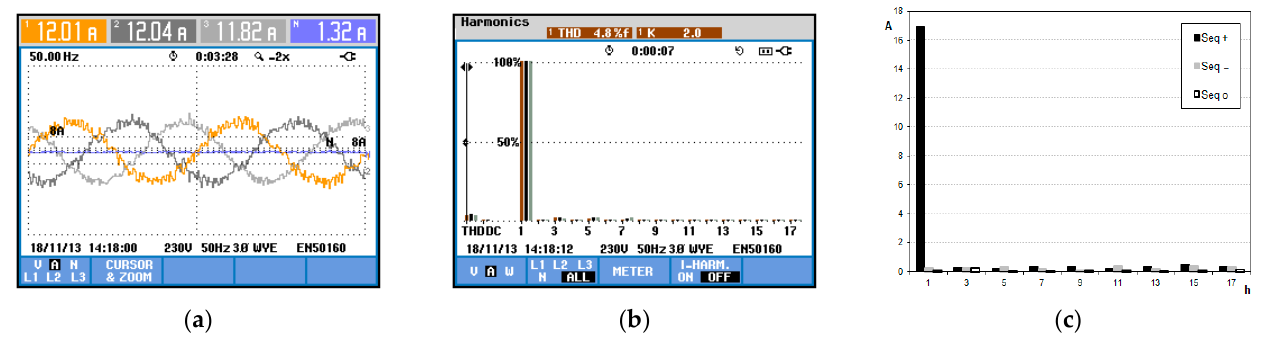
components (maximum values).